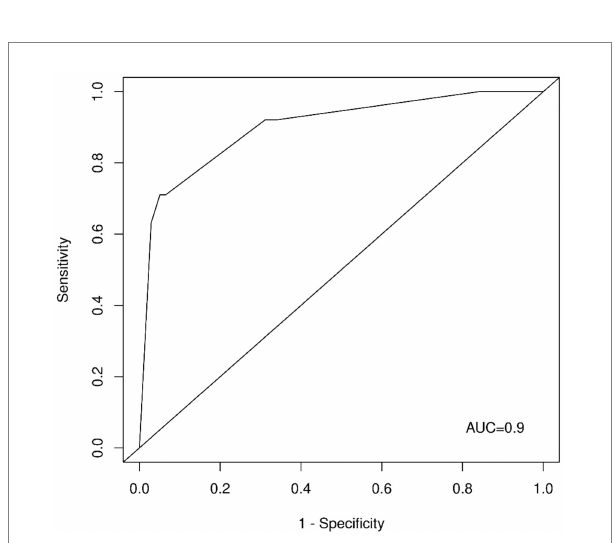
FIGURE 2 ROC curve for the LASSO regression score. AUC–area under the